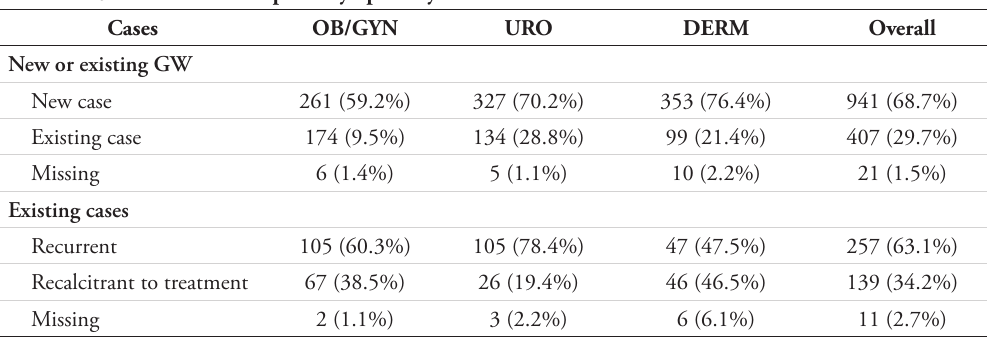
Table 3. GW Case Description by Specialty in